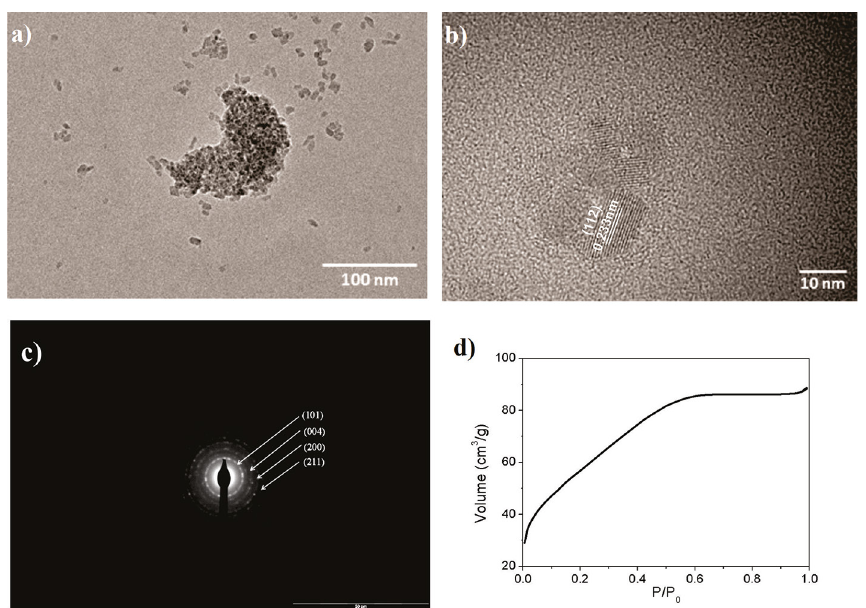
Figure 3: TEM images obtained with different magnifications (a) and (b), Electron Diffraction Pattern (c) and BET adsorption curve (d) for sample